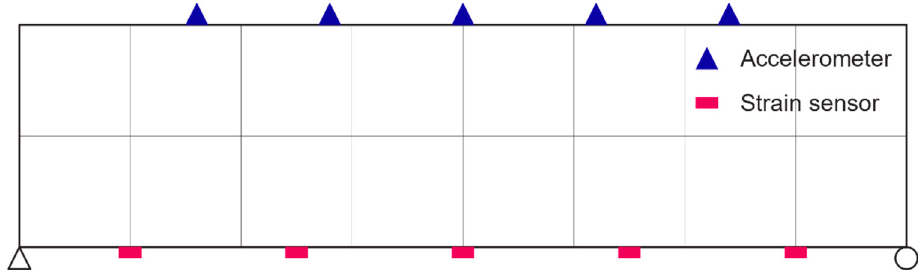
Figure 1. Mismatch of measurement location and finite element mesh.